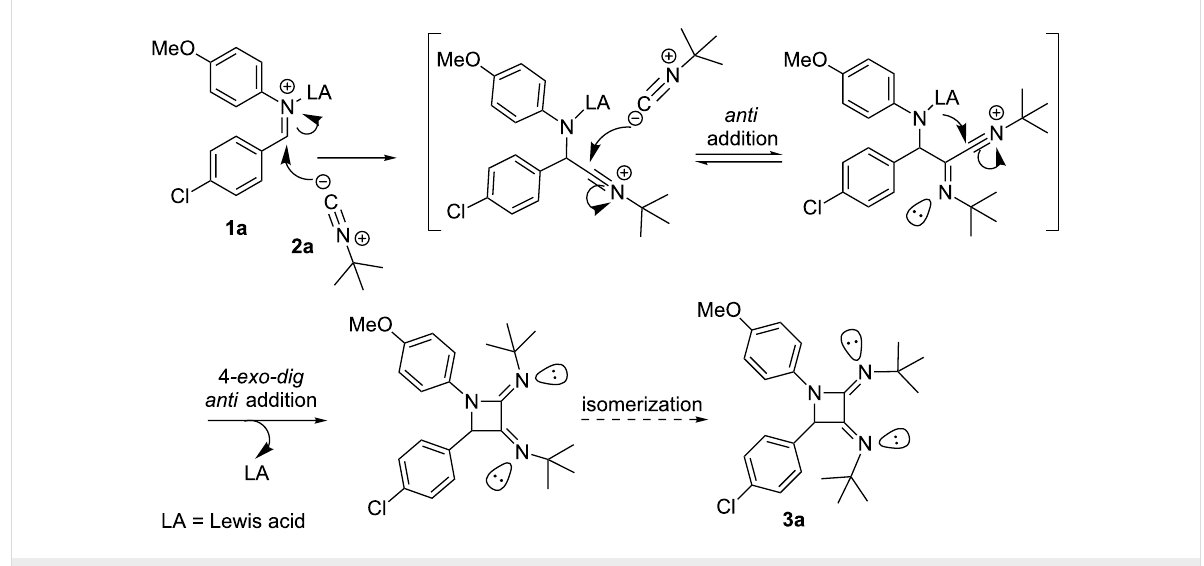
Scheme 3: Stepwise mechanism for the formation of azetidine 3a